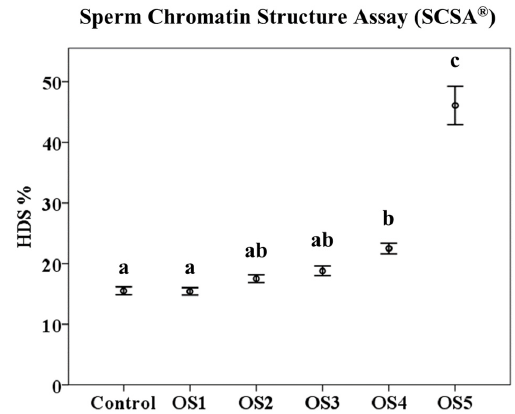
Figure 5. Effects of oxidant treatments on Sperm Chromatin Structure Assay (SCSA ® ) results. Mean of high DNA stainability (HDS %) ± standard error of the mean (mean ± SEM). a, b and c indicate significant differences ( p < 0.05). OS1 = 1 mM H 2 O 2 /0.1 µM FeSO 4 •7H 2 O; OS2 = 10 mM H 2 O 2 /1 µM